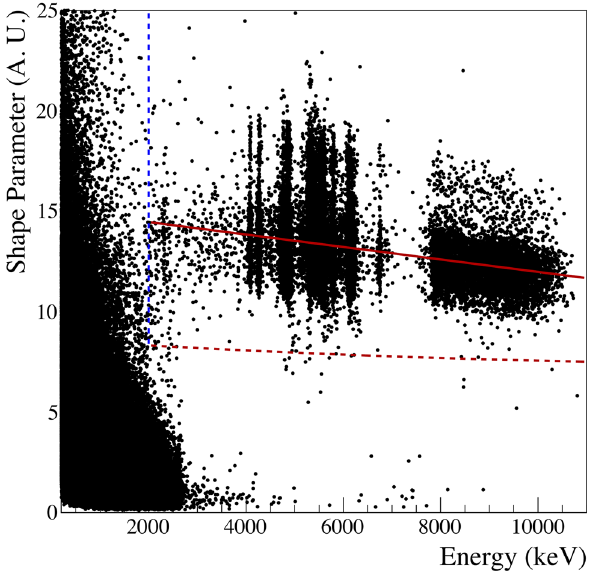
Fig. 1 Shape parameter (SP) of light pulses as a function of particle energy. The red solid line is the mean value of α particles SP, while the red dashed line at μ α ( E ) − 3 × σ α ( E ) is the boundary used to discriminate α from β/γ events. The blue dashed line at 2 MeV shows the energy below which the particle identification is not applied